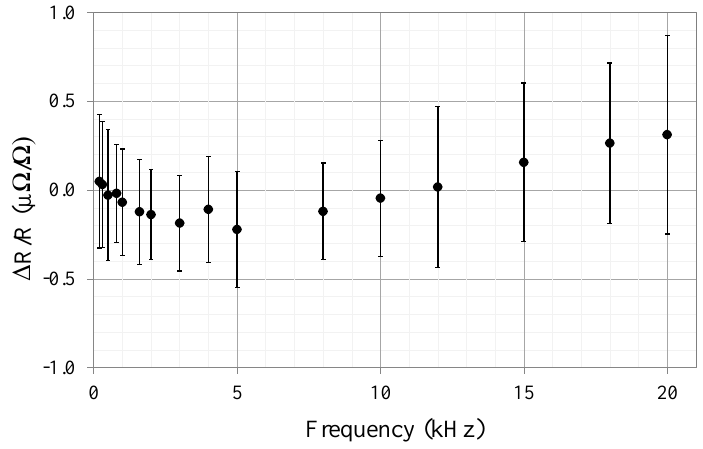
Figure 9. Graph of the relative difference between the measured and the calculated frequency dependence of the equivalent parallel resistance of the RC 10K-D5e and the HADDAD1000-1201 10:1 ratio, as a function of frequency [24].